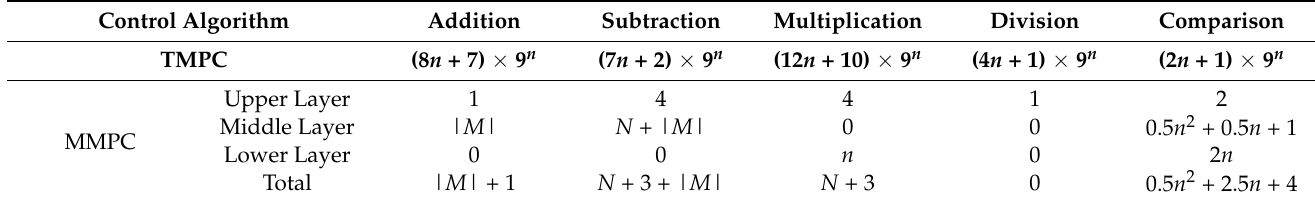
Table 4. Comparisons of computation complexity.